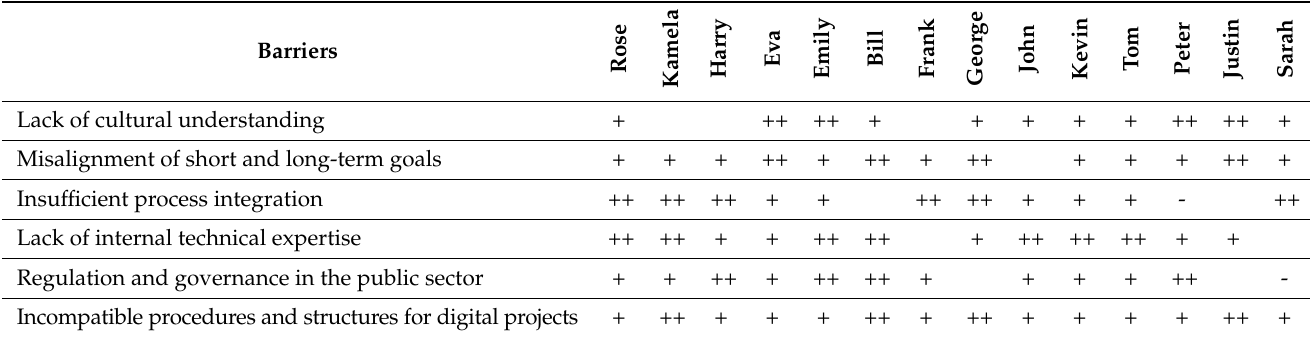
Table 3. Identified barriers to